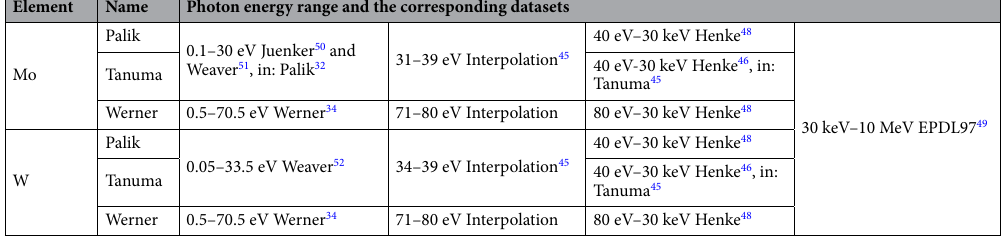
Table. 2. The optical ELF data used for Mo and